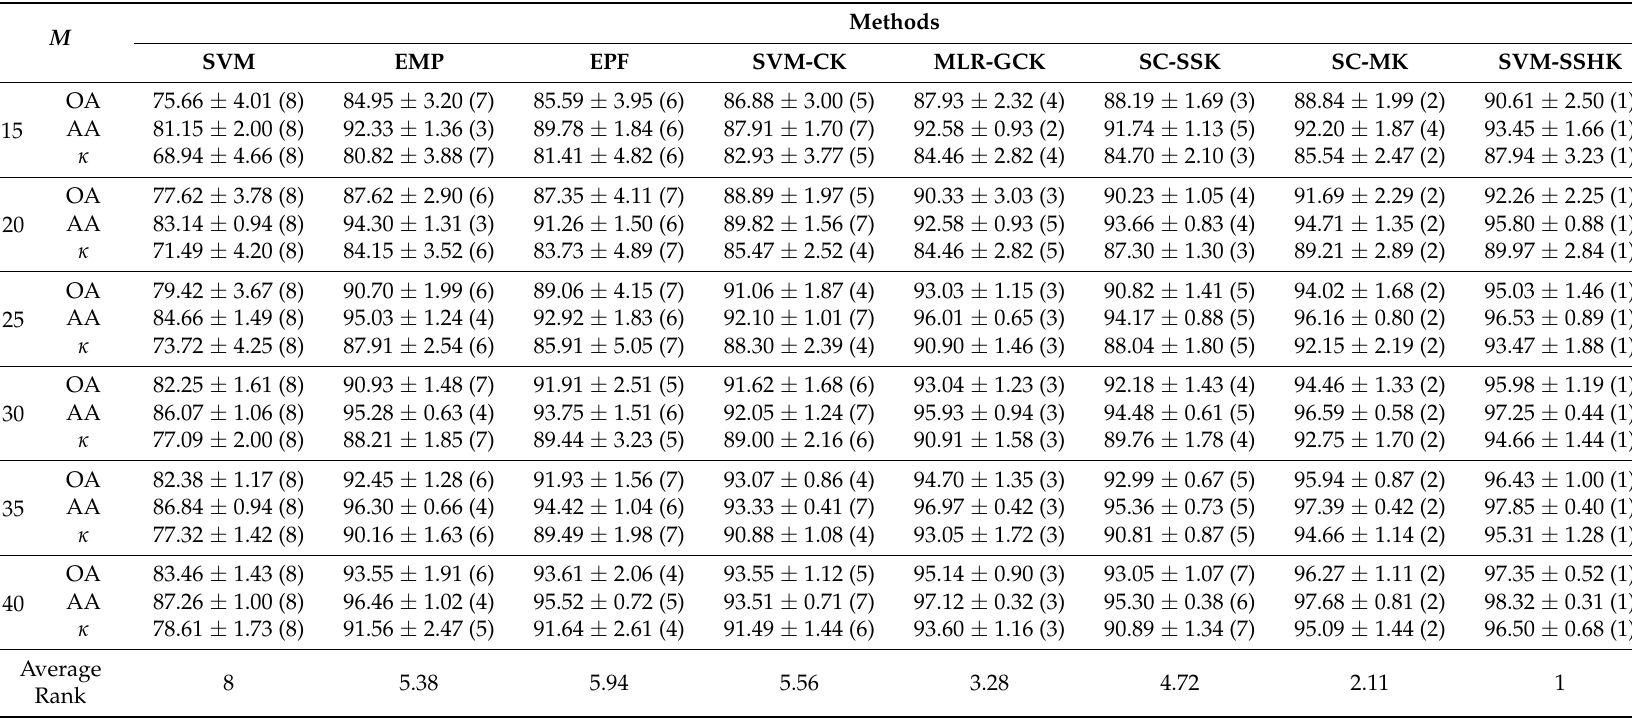
Table 5. Classification Results [Mean Accuracy (%) ± Standard Deviation] by Different Methods using Different Number of Training Samples for the UP Image. The best accuracies are indicated in bold in each